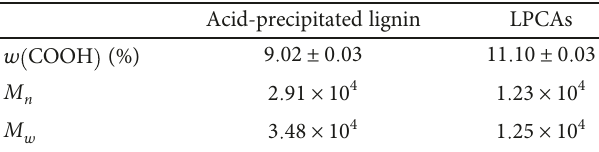
Table 2: The titration analysis and GPC characterization results of acid-precipitated lignin and